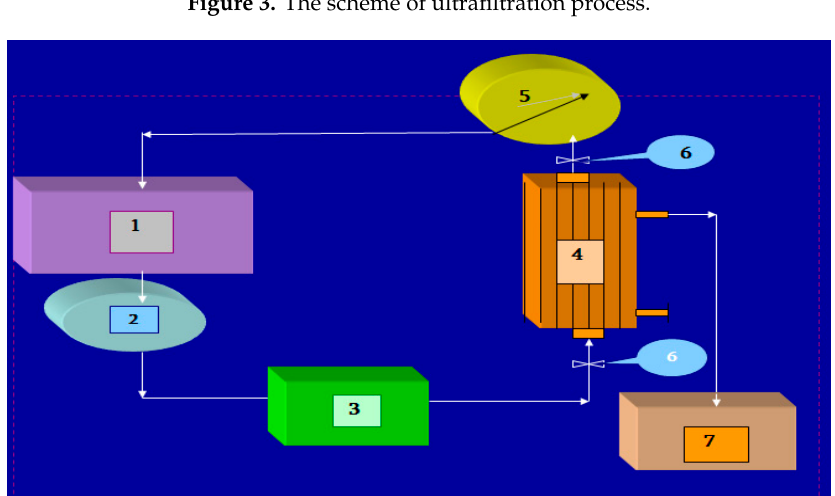
Figure 4. Technical scheme of ultrafiltration-dynamic mode: 1—pectin isolate volume, 2—pump, 3—mechanical filter, 4—membrane filter, 5—manometer, 6—tap, 7—filtrate volume.